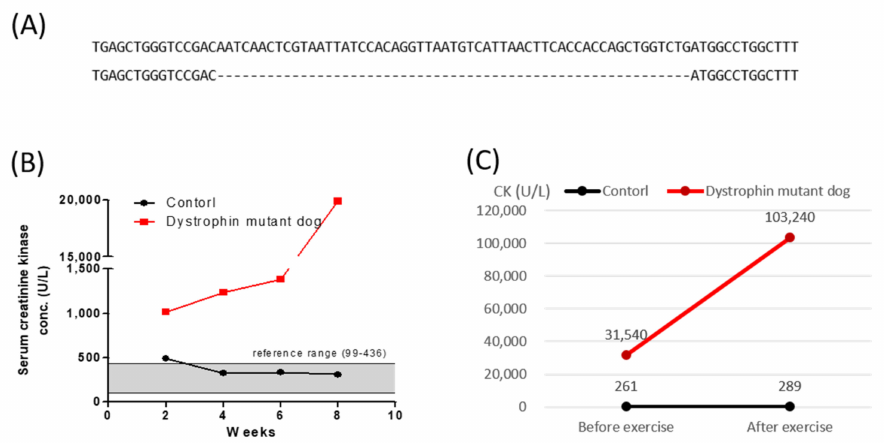
Figure 1. Production of a dystrophin mutant cloned dog by Cas9/sgRNA. ( A ) Sequences of target dystrophin locus detected in a cloned dog. The cloned puppy had a 57 bp deletion, and deleted sequences are shown. ( B ) Summary of serum creatine kinase (CK) values from two to eight weeks of age in the control and dystrophin mutant dog. ( C ) Change in creatine kinase in normal and dystrophin mutant dogs after